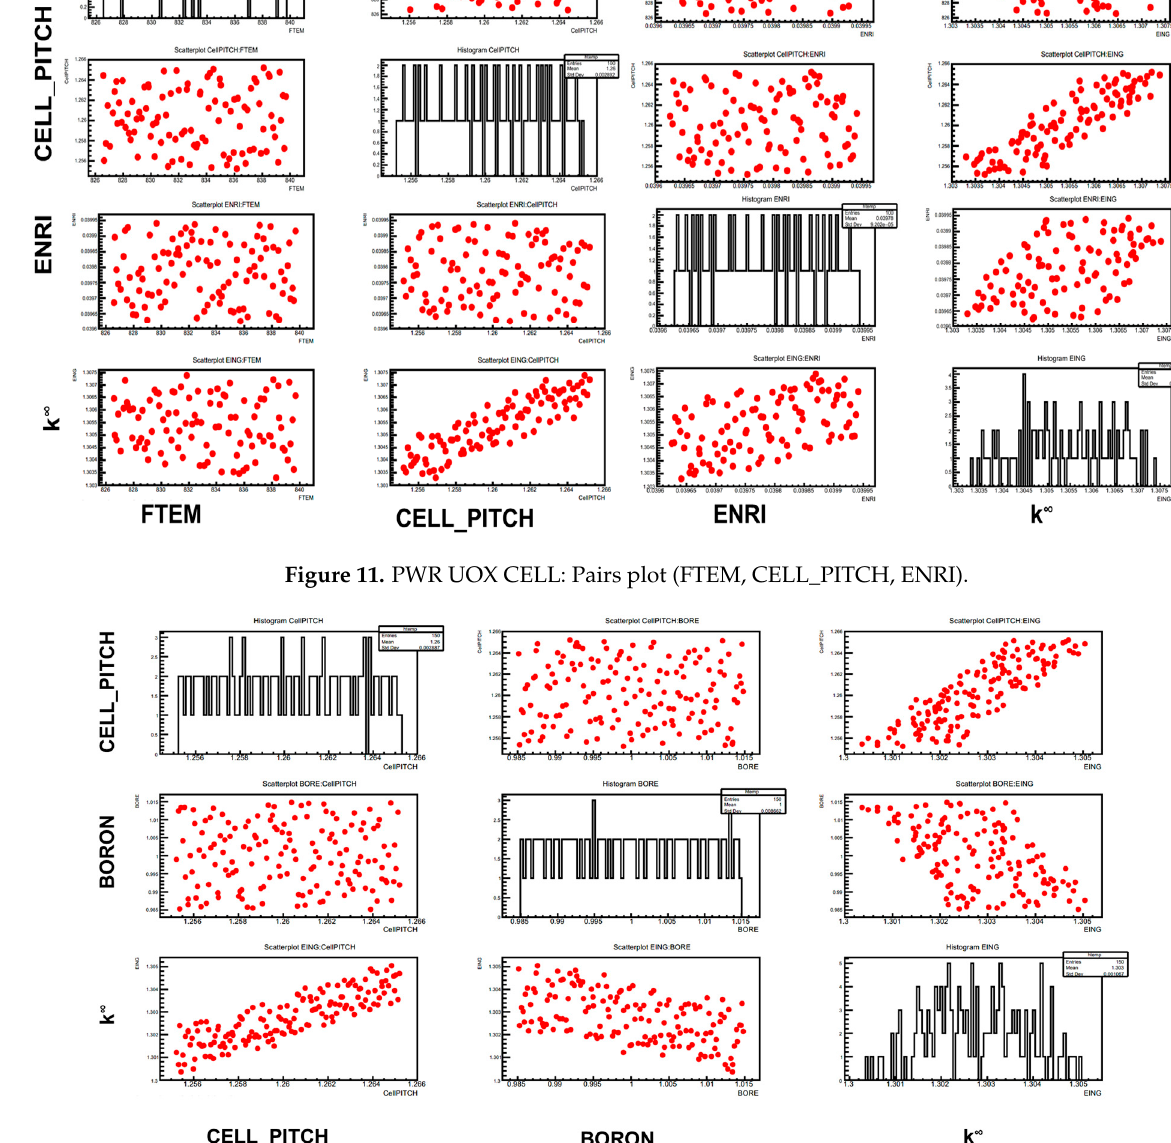
Figure 12. PWR UOX CELL: Pairs plot (CELL_PITCH, BORON). PWR MOX